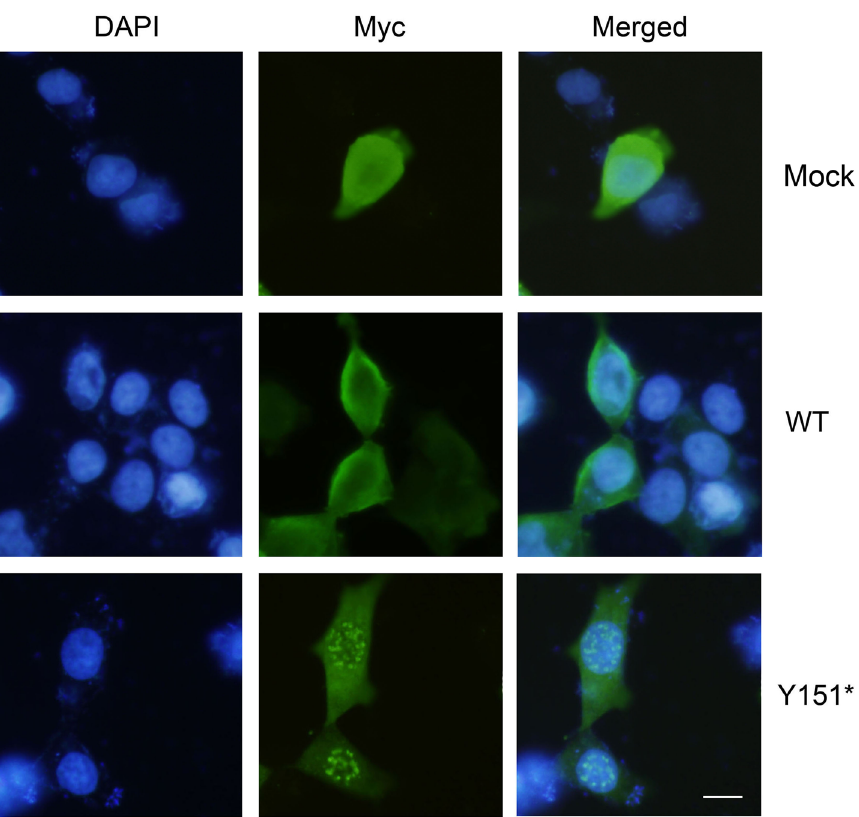
Fig 5. Localization of Myc-tagged wildtype or Y151 * CRYGD in HEK293T cells. Immunofluorescence of Myc (green fluorescence) showed the distribution of wildtype CRYGD in both cytomembrane and cytoplasm. However, the mutant CRYGD was mainly localized in the nucleus, in the form of granular deposits. Scale bar: 10 μ m.